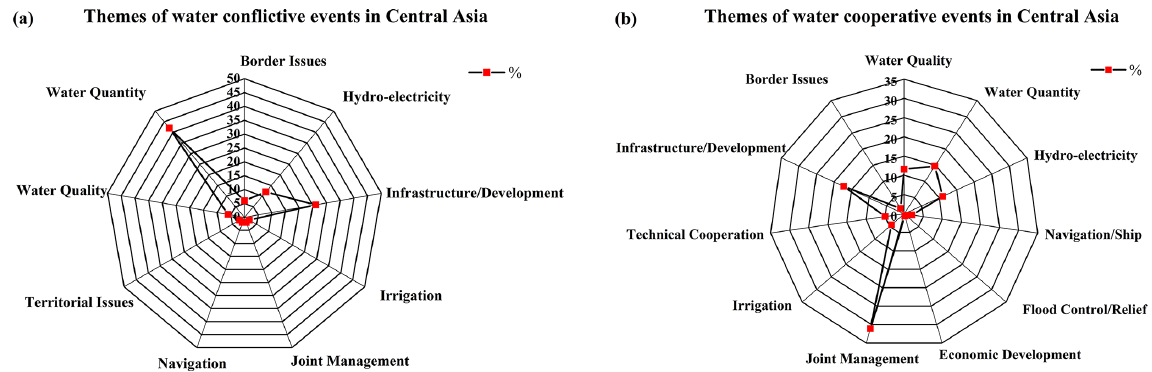
Figure 11. Percentages of (a) water conflictive and (b) cooperative events in Central Asia according to